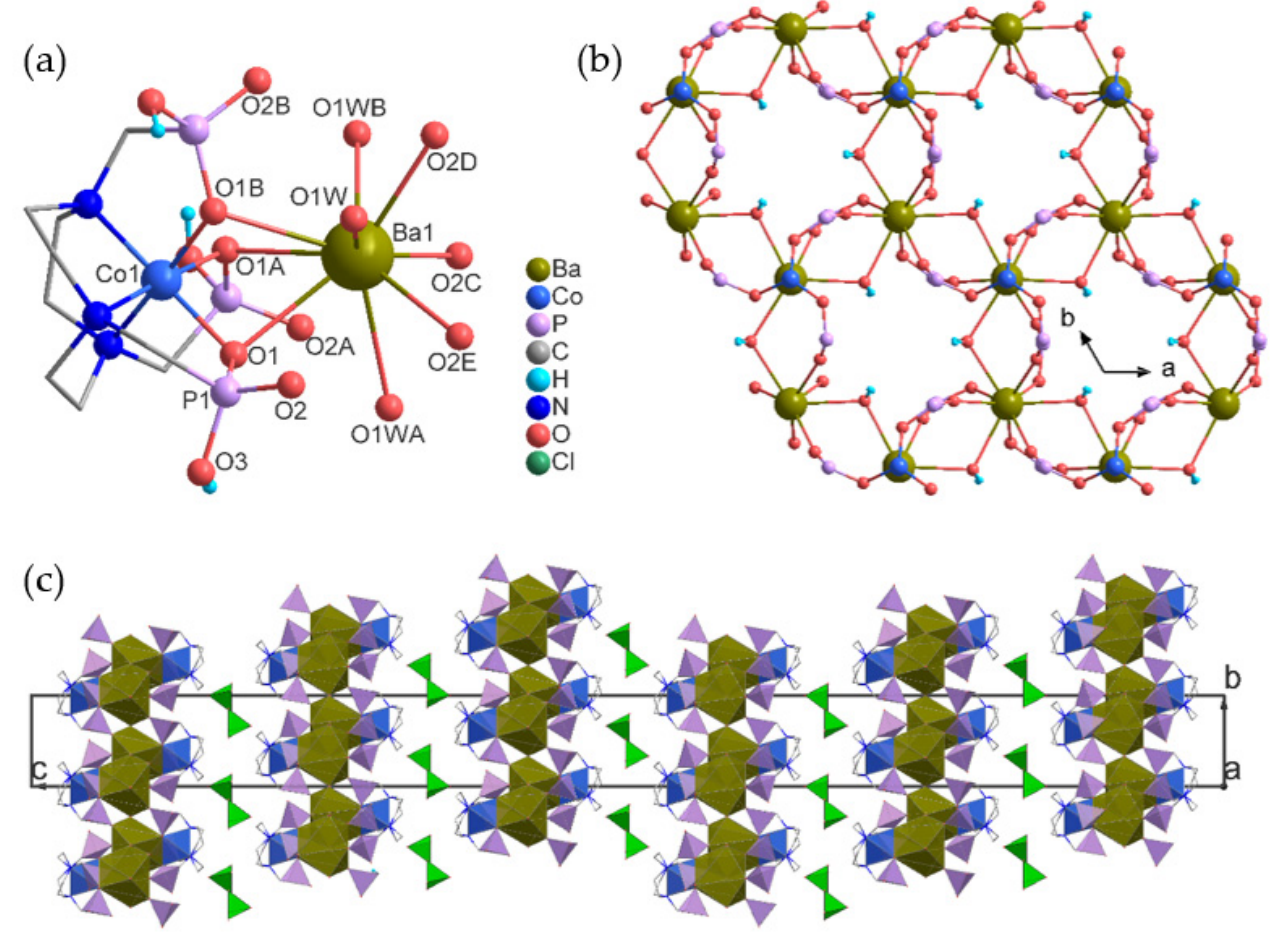
Figure 4. The crystal structure of CoBa ; the asymmetric unit ( a ), one hexagonal inorganic layer ( b ), and the ABCABC type of the three-dimensional packing diagram ( c ). All hydrogen atoms are omitted for clarity, except in the protonated phosphonate groups or water molecules.